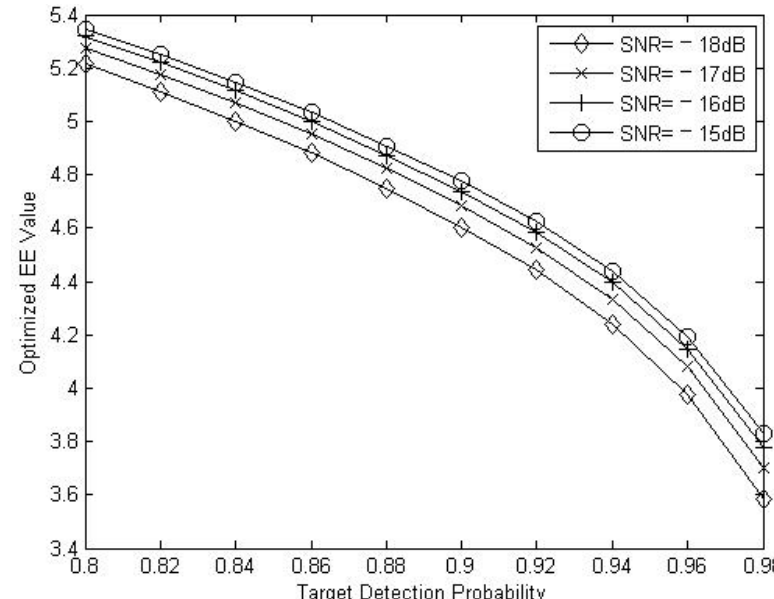
Figure 9. Optimal sensing ratio under target detection probability.